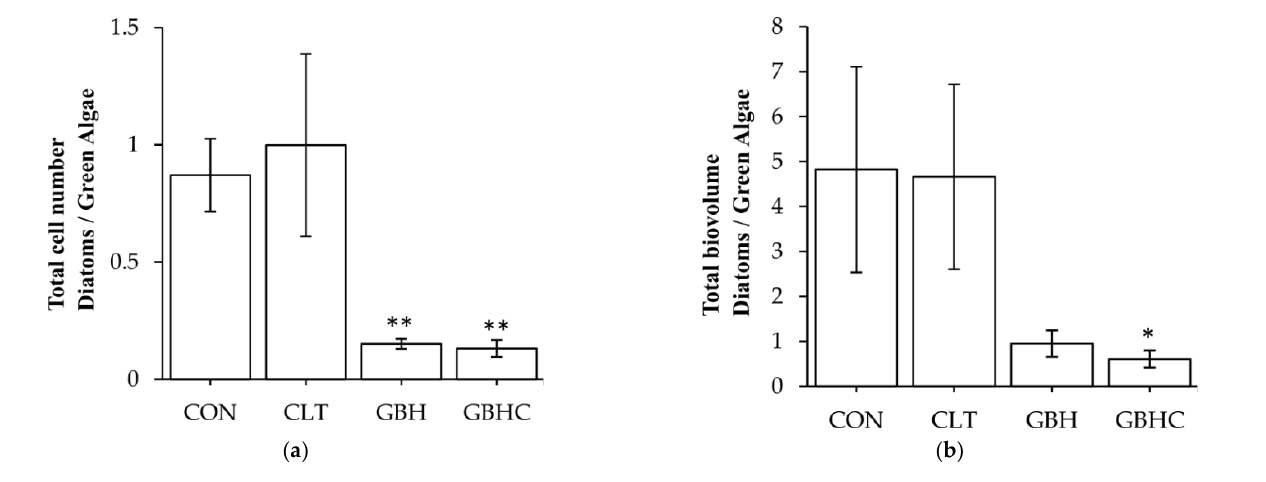
Figure 3. Ratio between diatoms and green algae in control (Con) and herbicide-treated biofilms (chlorotoluron (CLT), glyphosate-based herbicide formulation (GBH), and the combined application glyphosate-based herbicide formulation + chlorotoluron (GBHC)) as ( a ) total number of cells and ( b ) total biovolume. Values are means ± SE, n = 3, * = p < 0.05, ** = p < 0.001.